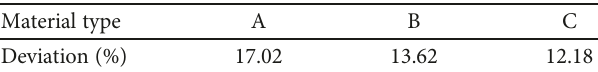
Table 5: Comparison between the crosslinked model and experimental result.